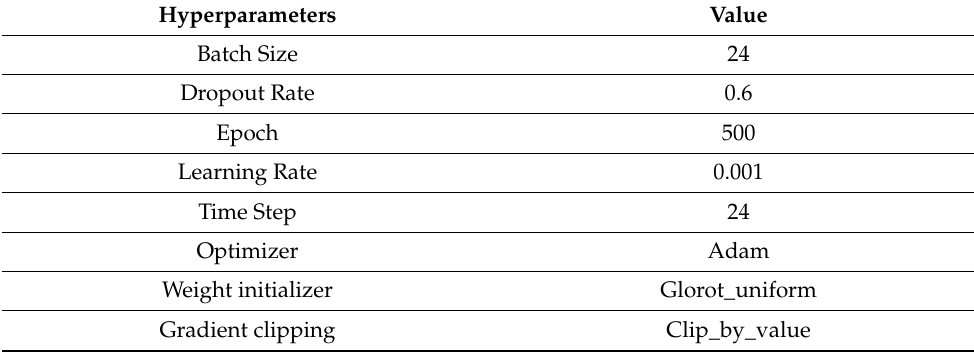
Table 2. Hyperparameters for training.